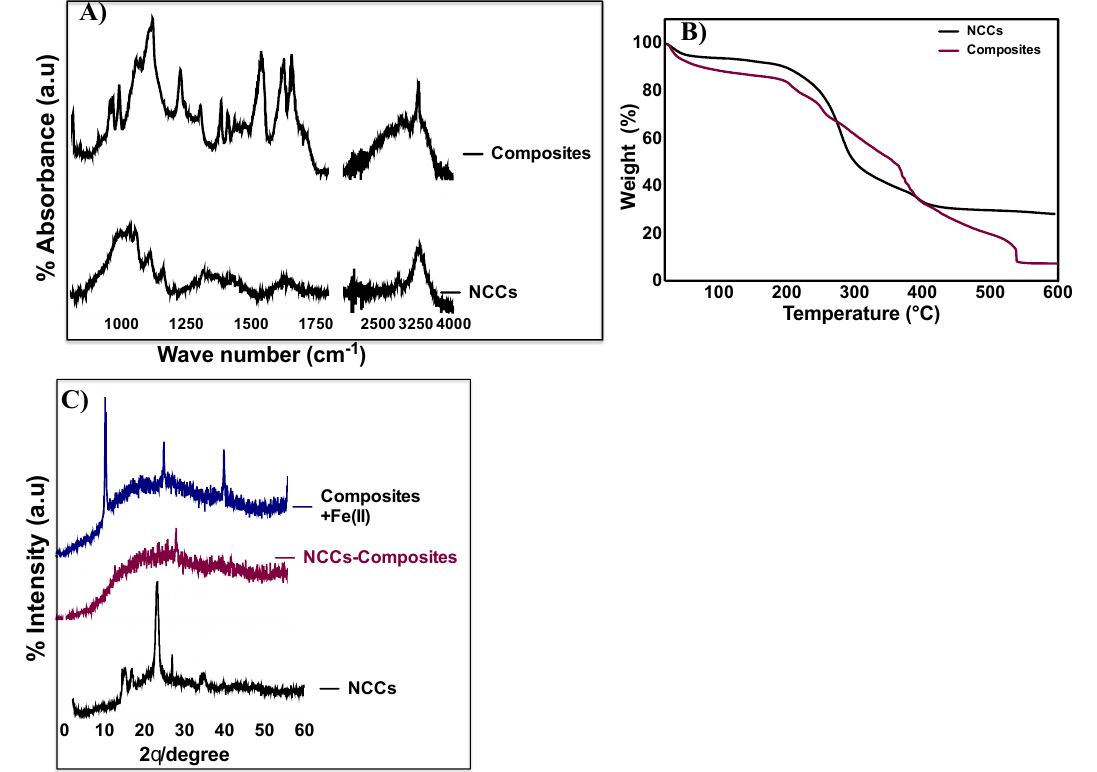
Figure 1. ( A ) FTIR spectra of NCC and embedded-NCC polymeric composite. ( B ) TGA analysis of Figure 1. (A) FTIR spectra of NCC and embedded-NCC polymeric composite. (B) TGA analysis of NCC and embedded-NCC composite. ( C ) XRD patterns of NCC, embedded-NCC polymeric composite, NCC and embedded-NCC composite. (C) XRD patterns of NCC, embedded-NCC polymeric and iron-loaded composite, and iron-loaded composite.